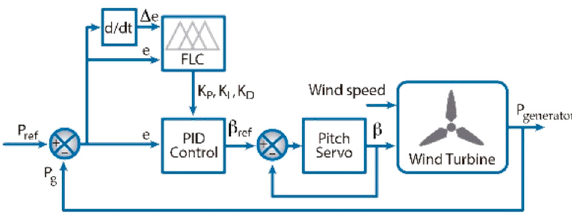
Figure 10. Adaptive control algorithm calculates the gains of a PID controller in real time; the strategy to change the values of the gains is done with FLC [52–54].